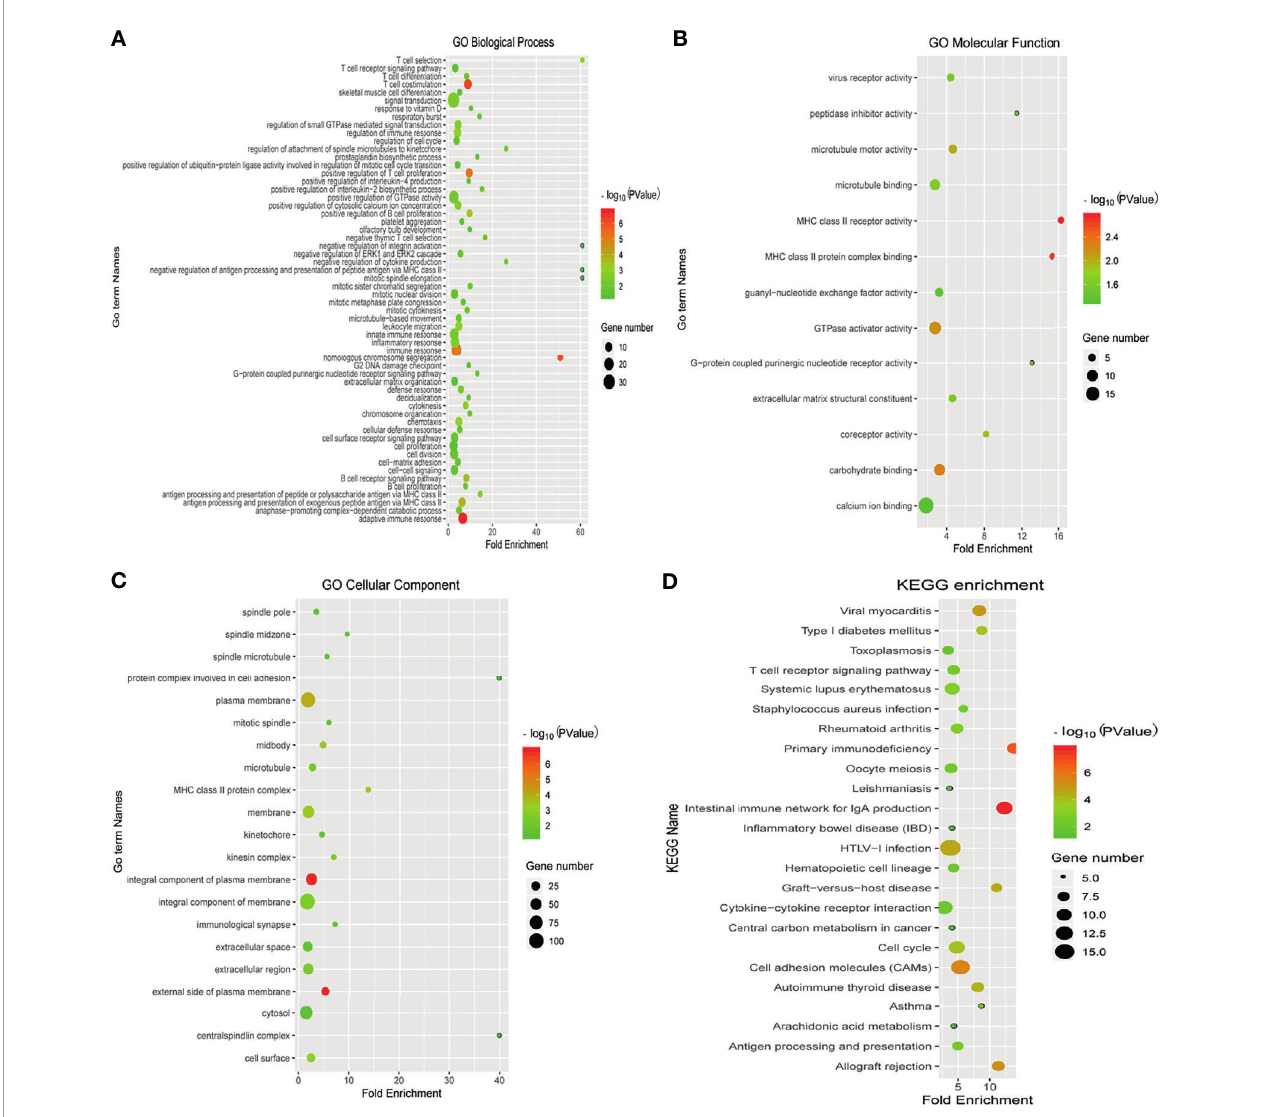
FIGURE 3 | Enrichment analysis of differentially expressed immune-related genes with prognostic value. The Gene Ontology (GO) terminology for biological processes (A) , molecular functions (B) , and cellular component terms (C) , and (D) the KEGG pathway enrichment analysis are depicted. Blue colour represents less enrichment to a pathway factor and red colour represents more number of factors enriched in a pathway. Black dots represent the number of enriched factors (the larger the number, the greater the